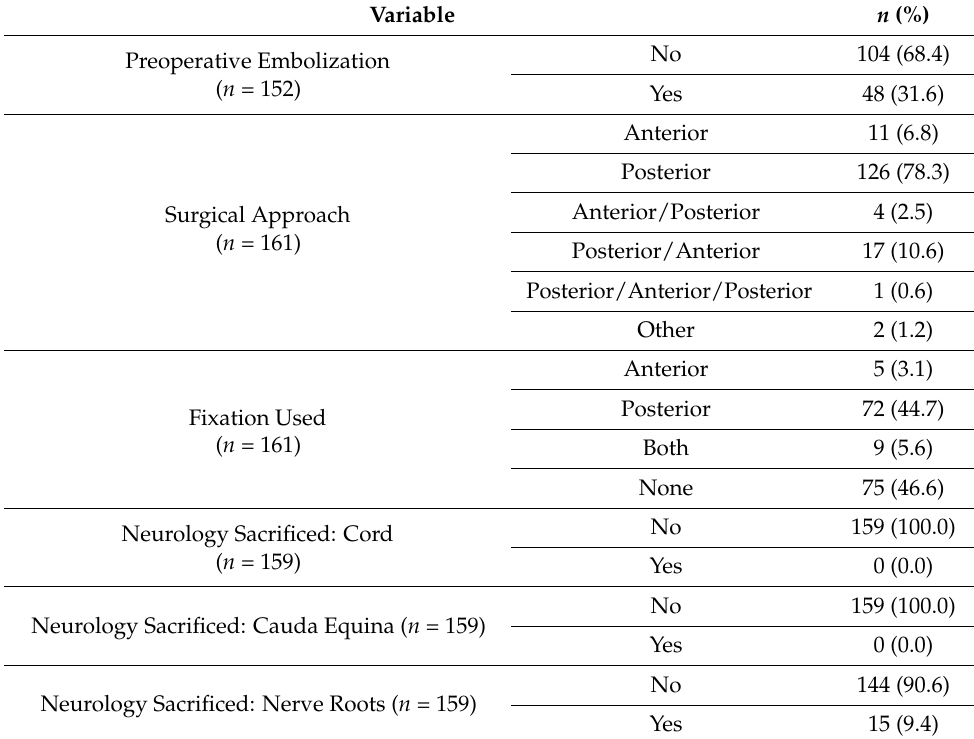
Table 3. Summary of treatment